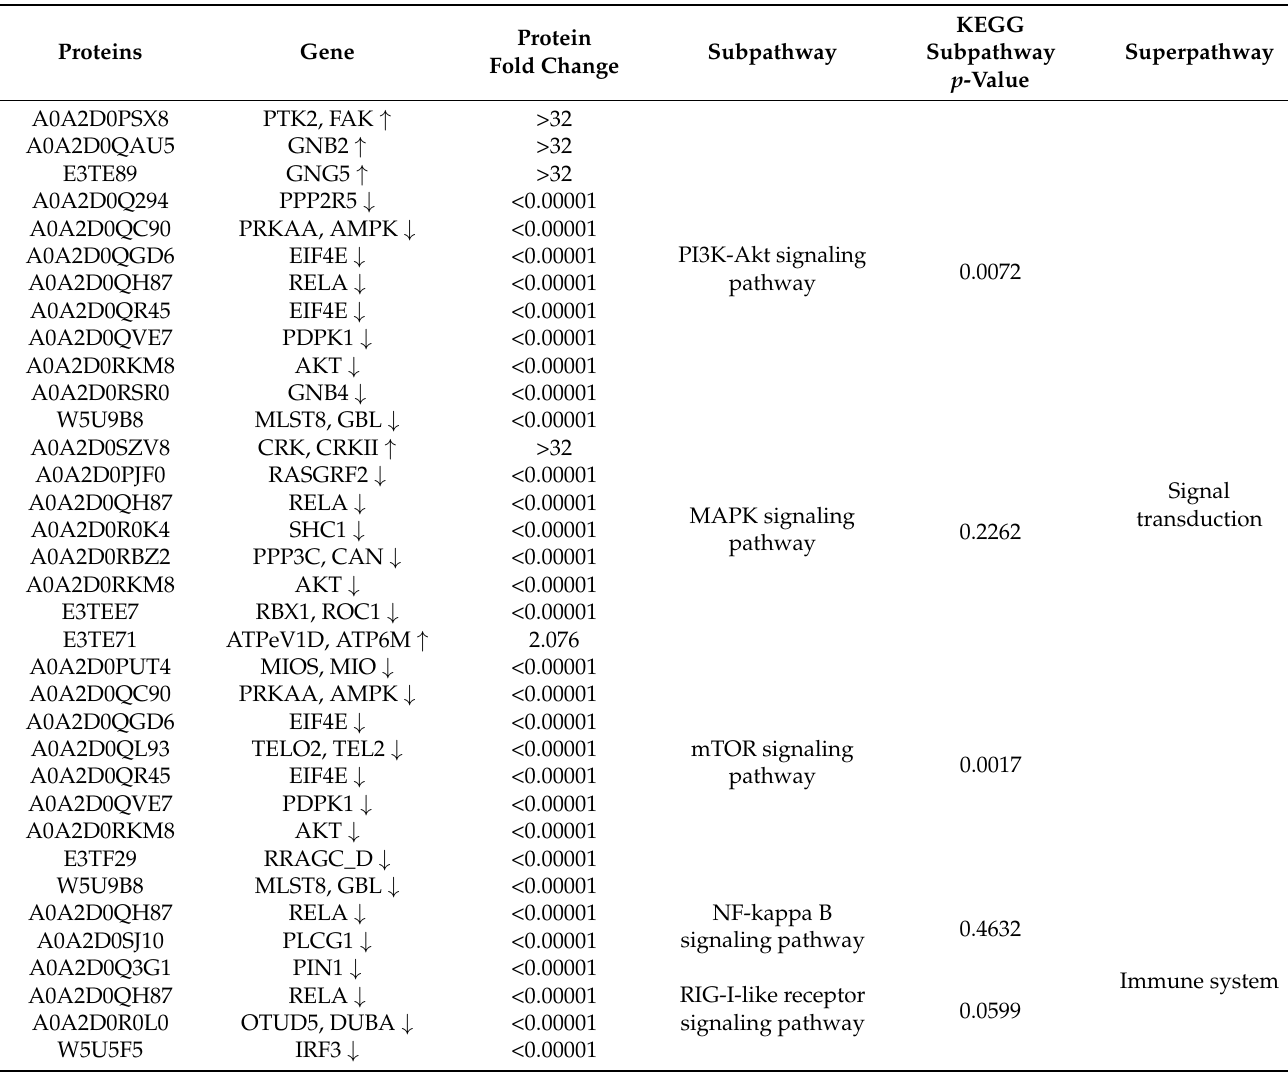
Table 4. Genes involved in some KEGG annotated pathways associated with the replication of